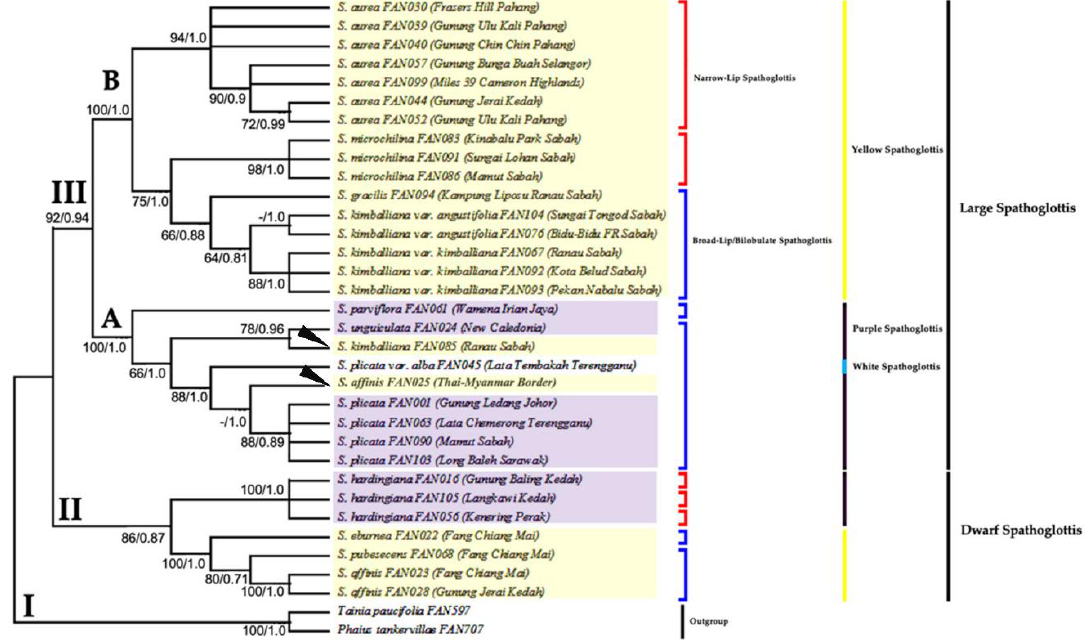
Figure 4. The combined majority-rule consensus tree results from ML analysis and optimal tree results from Bayesian analysis generated from the combined plastid gene dataset. Number below branches are bootstrap percentages ≥ 50 and probability values ≥ 0.5 (BS/PP). Clade II and III holds all 11 species and three infraspecific taxa (ingroups) of Spathoglottis ; Clade I indicates outgroup. Clade II comprises of the Dwarf Spathoglottis species, while Clade III consists of the Large Spathoglottis species. Clade III is further separated into subclades A and B; the Large Purple and Large Yellow Spathoglottis groups, respectively. Groupings of taxa were also based on the shape of the labellum; either narrow or broad/bilobulate. Both clades of Dwarf and Large Spathoglottis (Clade II and Clade III) are monophyletic.